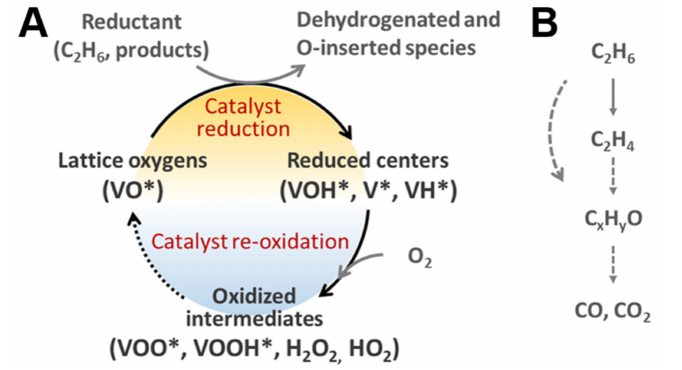
Figure 4. ( A ) Catalytic redox cycles, and ( B ) C 2 H 6 conversions involved in C 2 H 6 -O 2 reactions on vanadium oxide. Adapted from ref. [57], Copyright (2021), with permission from John Wiley &